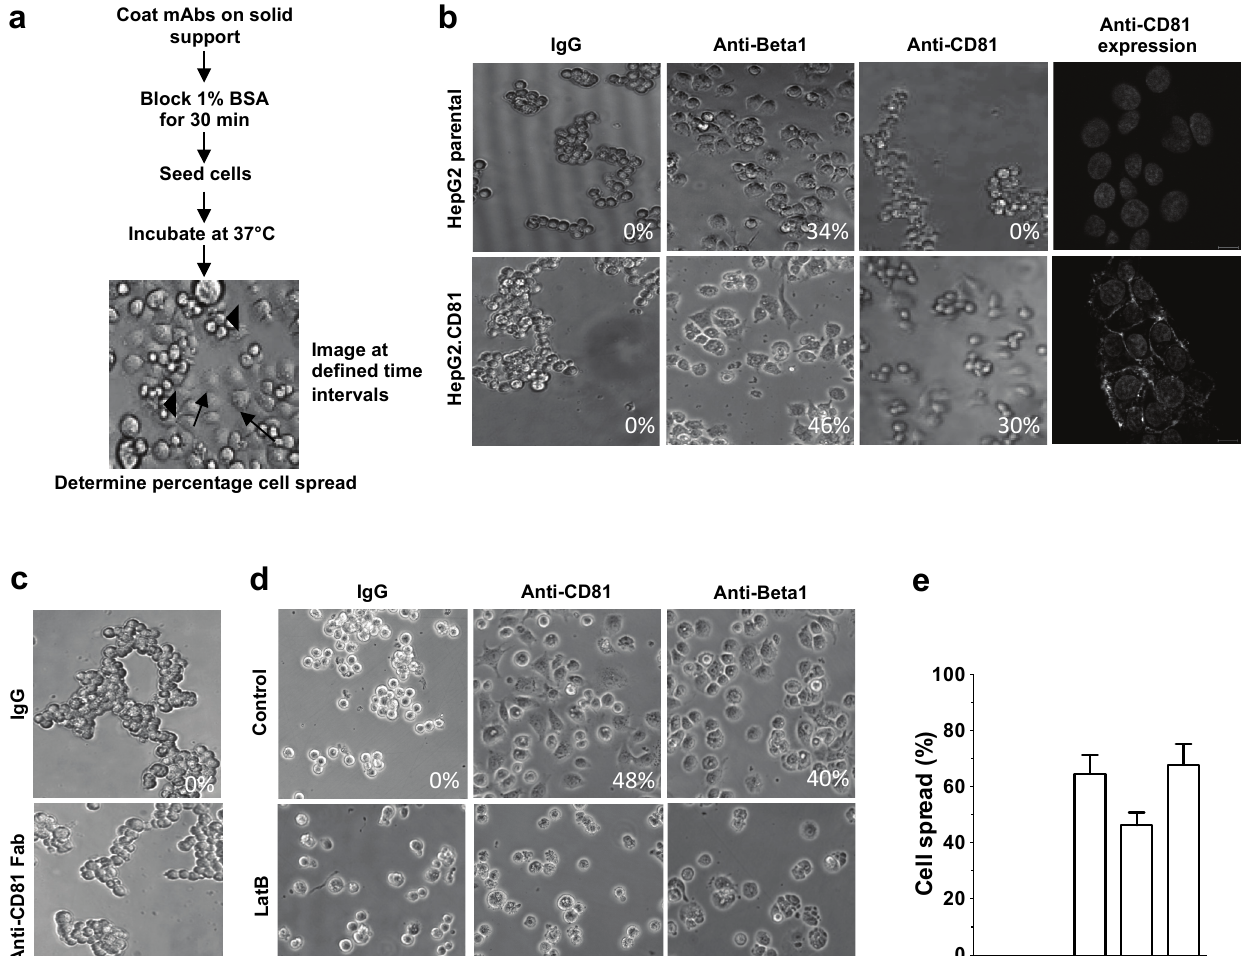
Figure 2. CD81 engagement promotes hepatoma spread. Cartoon depicting cell spread assay. Spreading cells (arrows) and non-spreading cells (arrow heads) are annotated ( a ). Confocal images of CD81 expression (1s262, 5 µg/mL) in HepG2 cells, phase images of parental HepG2 or HepG2.CD81 spread following IgG control (5 µg/mL), anti-CD81 (1s262, 5 µg/mL) or anti-Beta-1 (5 µg/mL) ligation for 6 h ( b ). Phase images of HepG2.CD81 cell spread following IgG control (5 µg/mL), anti-CD81 Fab or whole IgG (2s66, 5 µg/mL) ligation for 6 h ( c ). Phase images of HepG2.CD81 spread following treatment with Cytochalasin D, Latrunculin B or control DMSO in response to IgG control (5 µg/mL), anti-CD81 (1s262, 5 µg/mL) or anti-Beta1 (5 µg/mL) ( d ). Quantification of Huh-7.5 spread following anti-SRBI, anti-CD81, anti-CD9, anti-CD151 or isotype control IgG (5 µg/mL) ligation for 1 h ( e ). Data presented are from an individual experiment representative of at least three independent experiments and include quantification of cell spread expressed as a